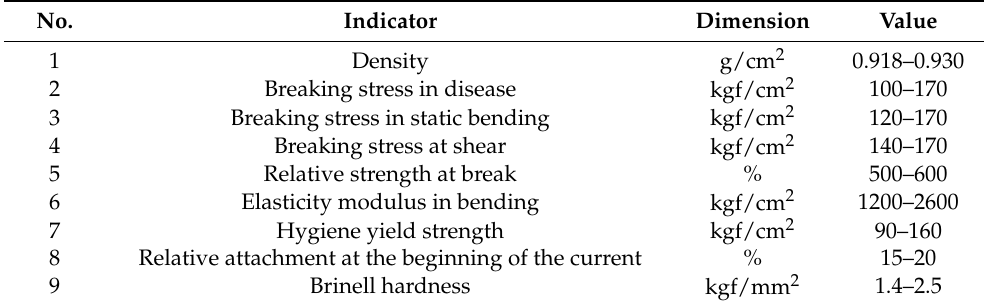
Table 2. Physical and chemical LDPE properties